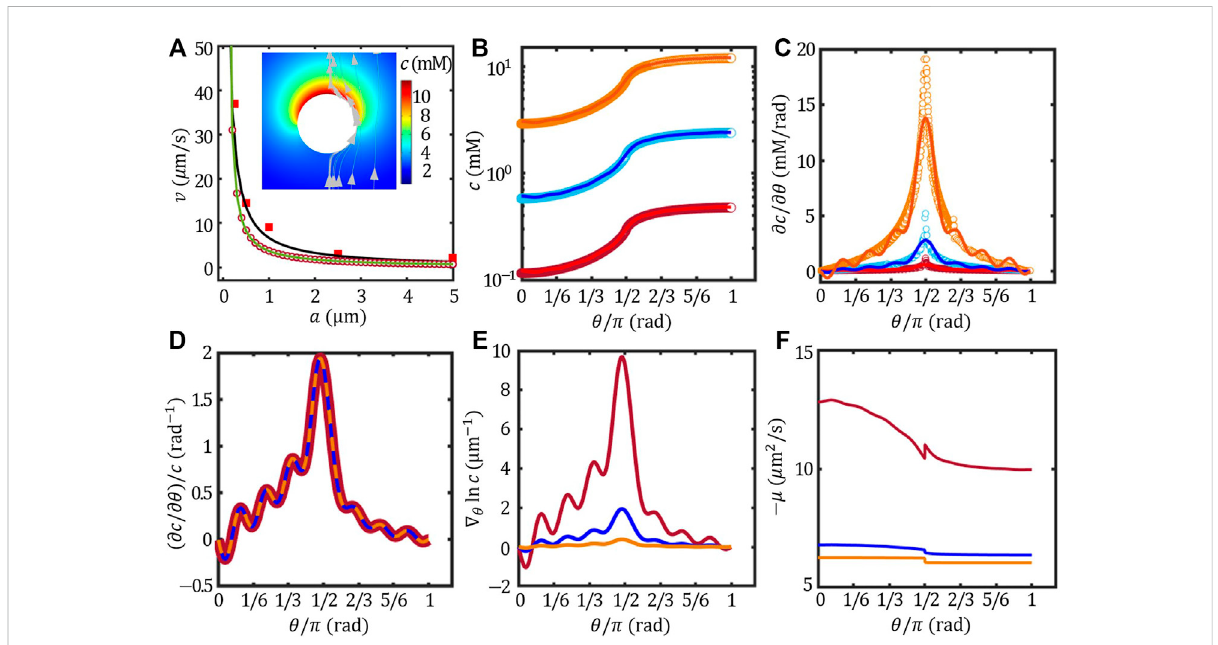
FIGURE 4 Effect of the colloidal size (A) (A) The velocity of the Pt/PS Janus colloids as a function of size (A) experimental results (red square, re-plotted from Ref. (Ebbens et al. (2012)), far- fi eld approximation (black line), FEM (red circle) and Legendre expansion method of n = 15 (green line). The inset presents the concentration fi eld and fl ow fi eld of the Janus of a = 5 μ m. The angular distribution of surface concentration c (B) , the corresponding tangentialgradient z c / z θ (C) ( z c / z θ )/ c (D) , ∇ θ ln c (cid:1) ( 1 a z c z θ ) / c (E) andtheoppositeofsurfacemobility − μ (F) : a =0.2 μ m(red),1 μ m(blue)and5 μ m (brown). Circles are obtained from FEM and lines are from Legendre expansion method of n = 15.